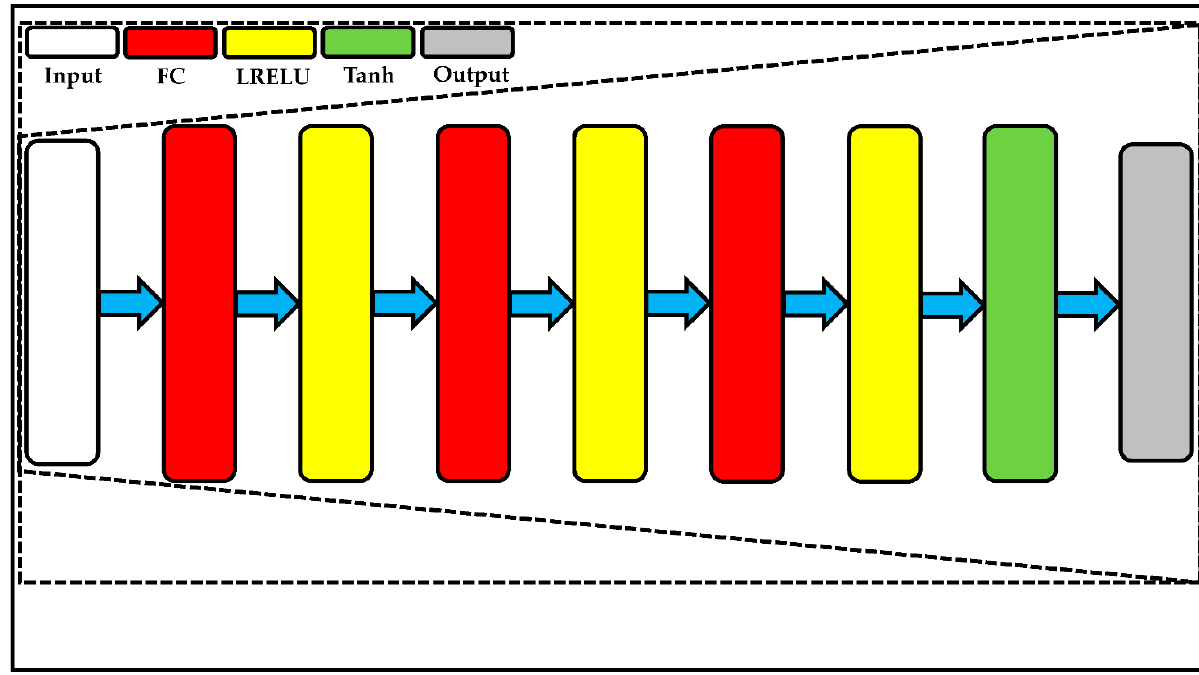
Figure 12. Composition of the encoder.